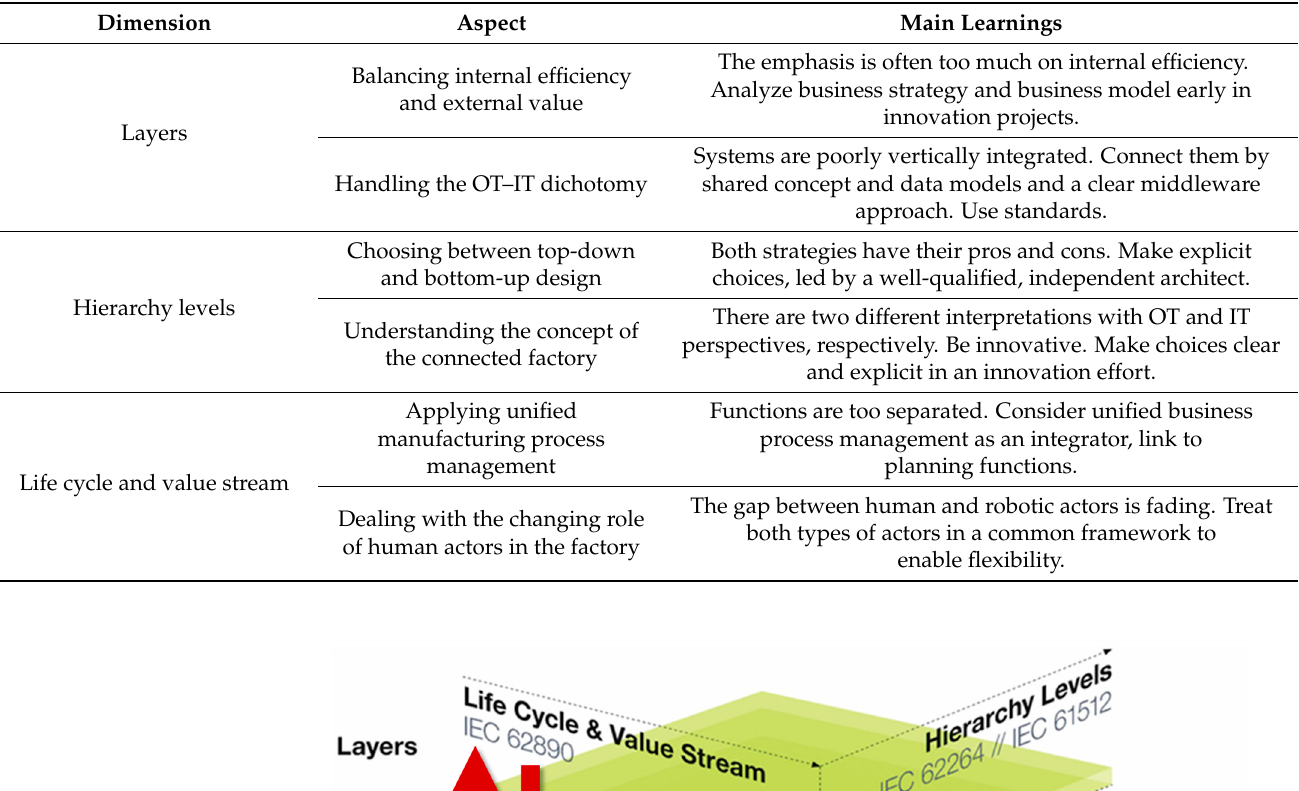
Table 1. Summary of learnings from two decades of projects.